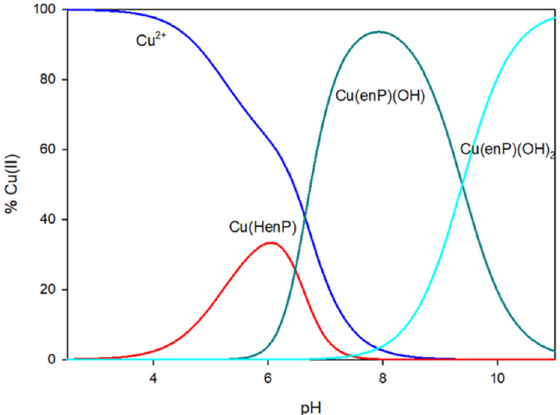
Figure 1. Distribution diagram for Cu(II) and phosphoethanolamine (ratio 1:1) .